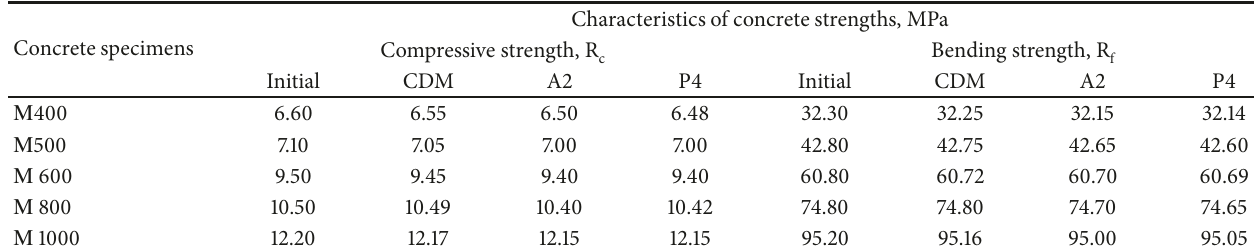
Table 1: Alteration of strength characteristics of concrete during 28 days of exposure in Czapek Dox medium without inoculation (CDM) and inoculated by spores of Aspergillus fumigatus A2 and Penicillium brevicompactum P4. Characteristics of concrete strengths, MPa Concrete specimens